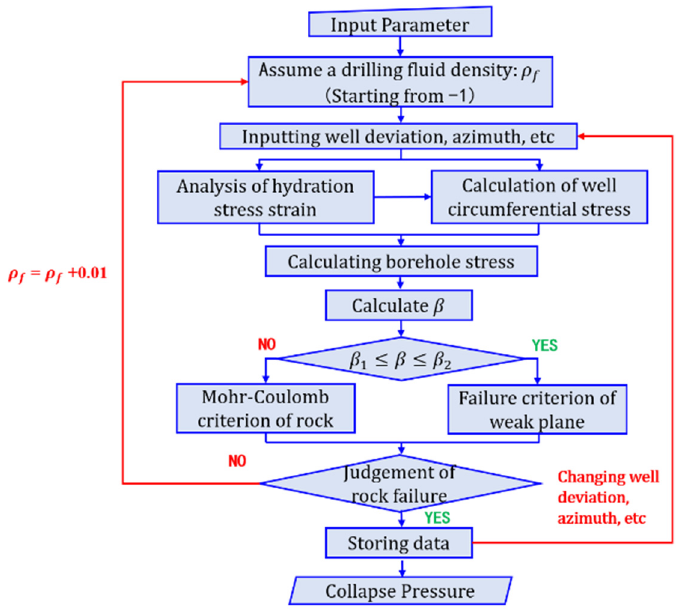
Figure 7. Solution flow of collapse pressure.